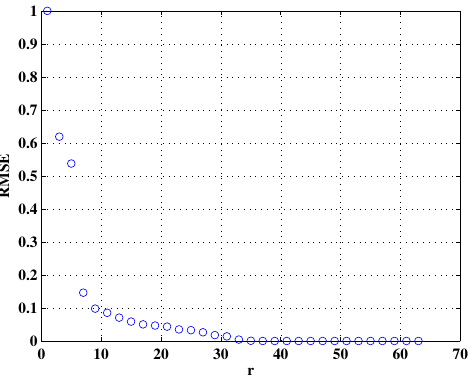
Figure 3. Root Mean Square Error (RMSE) values between the rank- r approximated matrix D r and the original matrix D with respect to different values of r